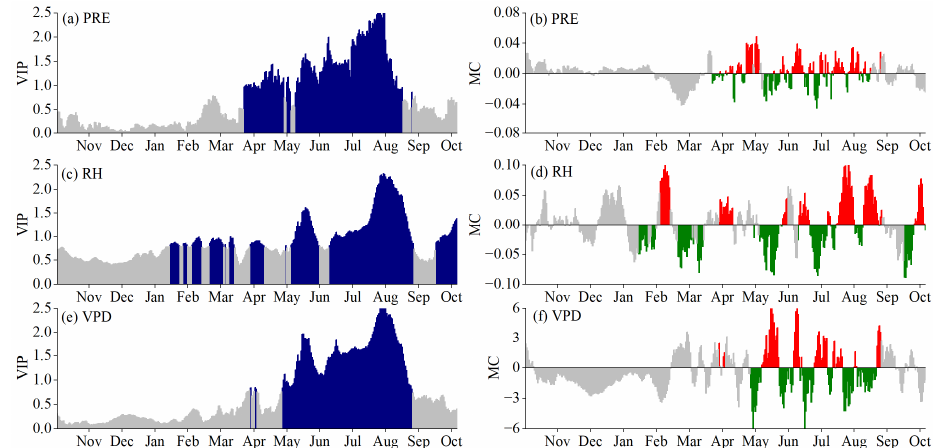
Figure 9. Results of partial least squares (PLS) regression correlating the end of the growing season (EOS) from 1985–2018 with 31-day running means of climatic factors. ( a , b ) Daily precipitation (PRE), ( c , d ) daily relative humidity (RH) and ( e , f ) vapor pressure deficit (VPD) from the previous November to October of the year.